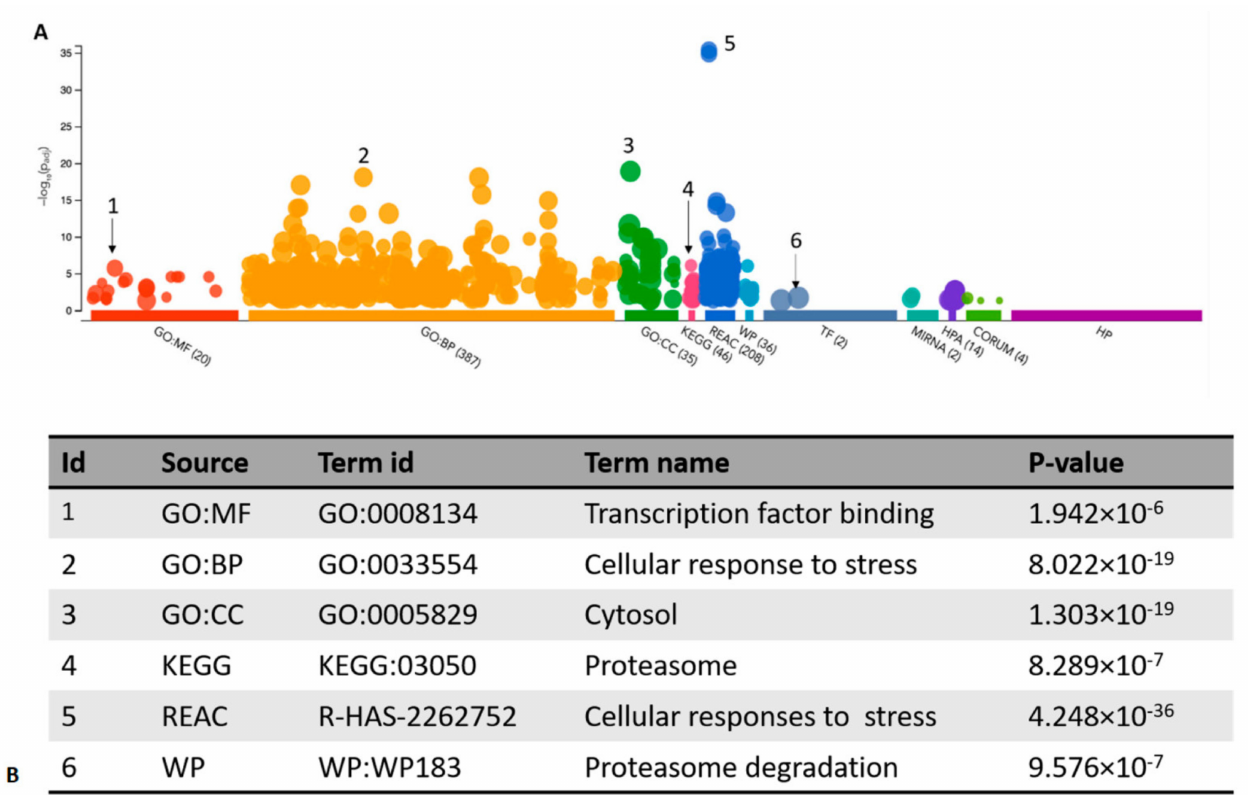
Figure 2. g:Profiler analysis of 85 targets. ( A ) Graphic representation of the results. ( B ) The most significant results for Gene Ontology (GO) and pathways enrichment were shown. GO molecular function (GO:MF); GO biological process (GO:BP); GO cellular component (GO:CC); Kyoto encyclopedia of genes and genomes (KEGG); Reactome (REAC); WikiPathways